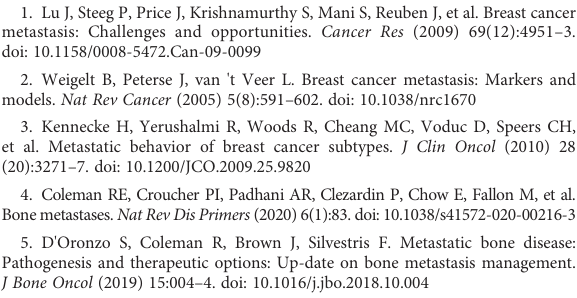
SUPPLEMENTARY FIGURE 9 Breast cancer-speci fi c survival of bone metastatic breast cancer patients strati fi ed by acceptance of radiotherapy, (A) accept radiotherapy, (B) no